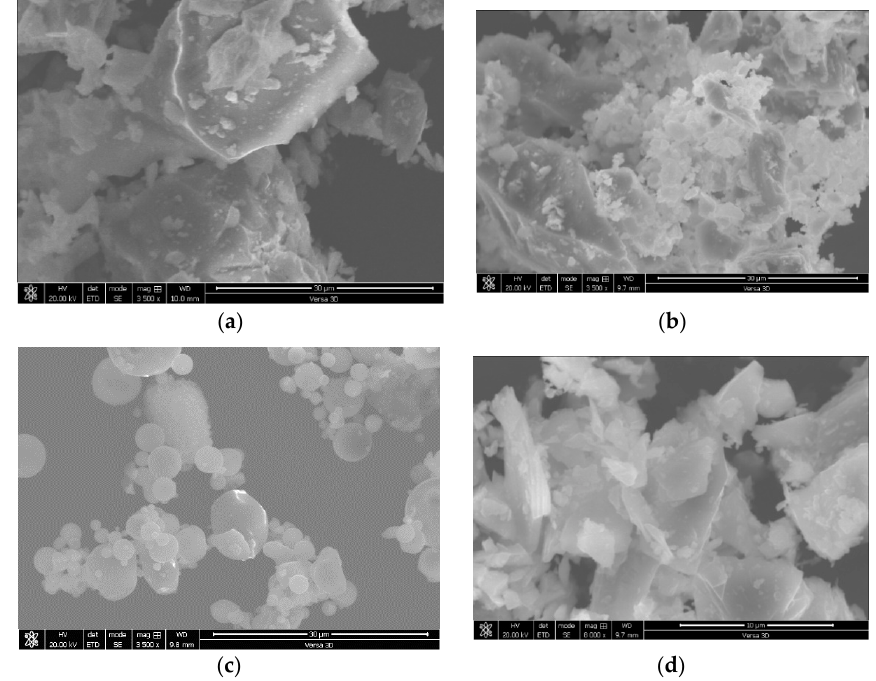
Figure 3. SEM images of ( a ) NP1, ( b ) NP2, ( c ) FA, and ( d ) GSF.